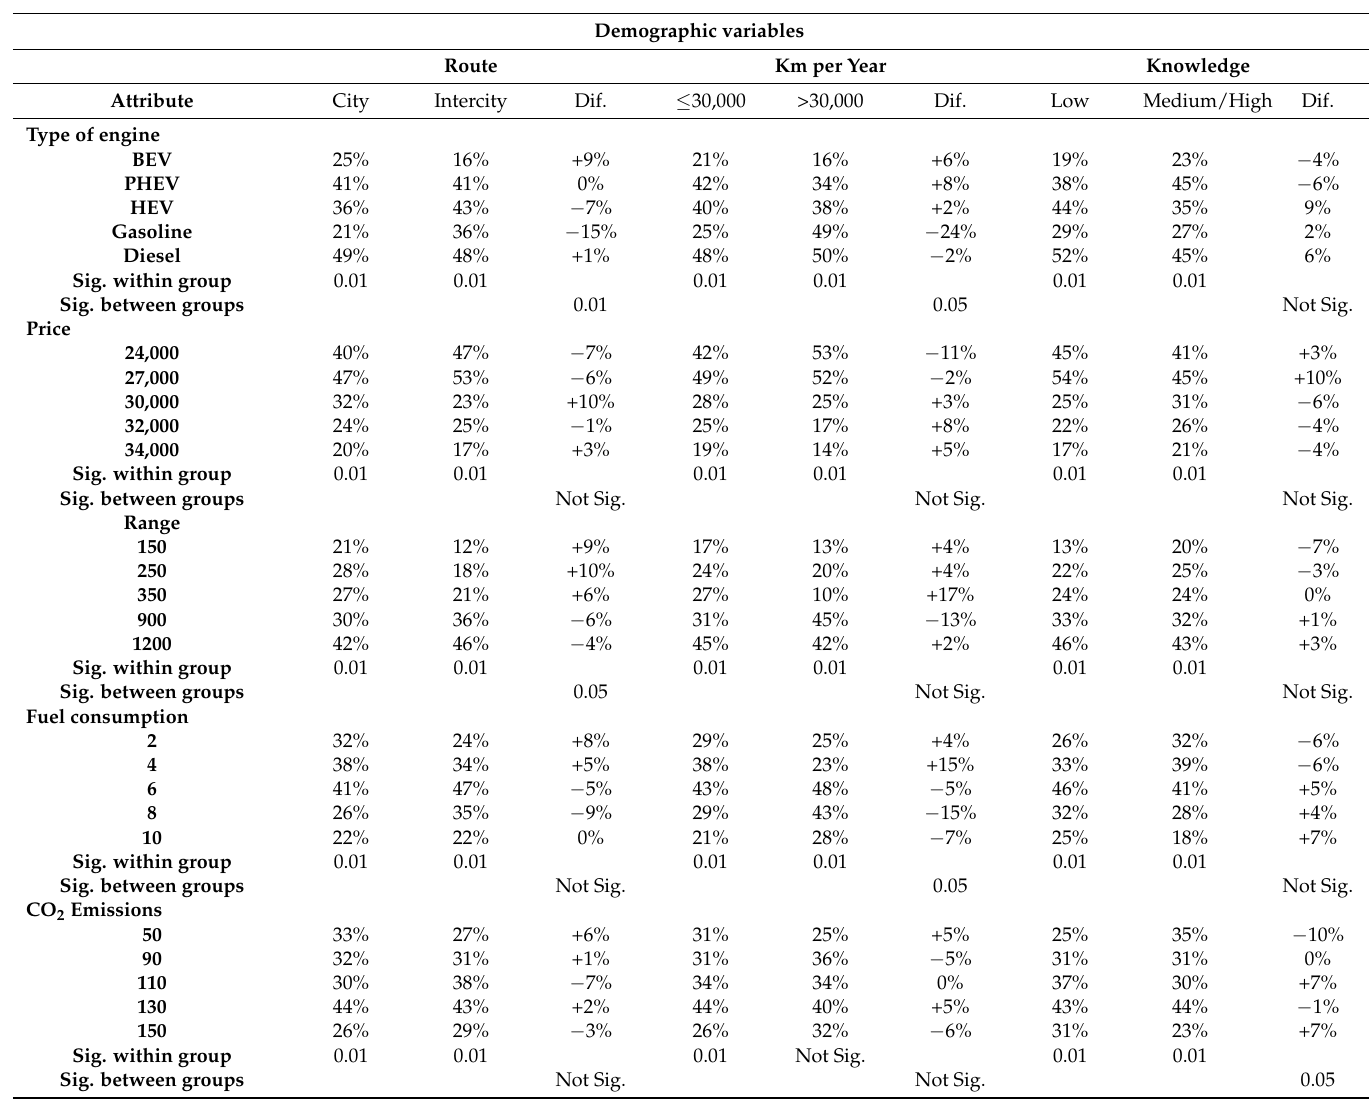
Table 6. Counting analysis for each consumer characteristics